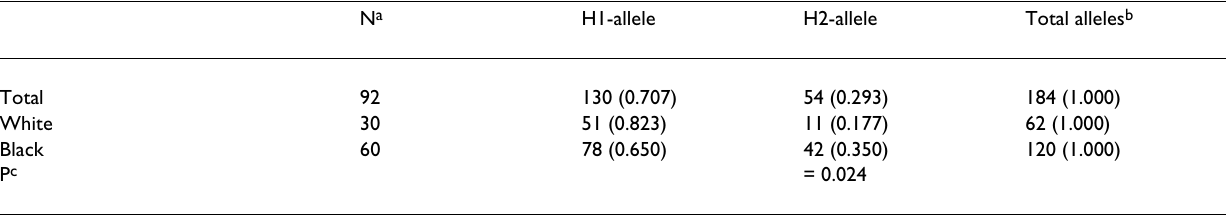
Table 1: APOC1 Gene Allele Frequency in 92 Human Subjects N a